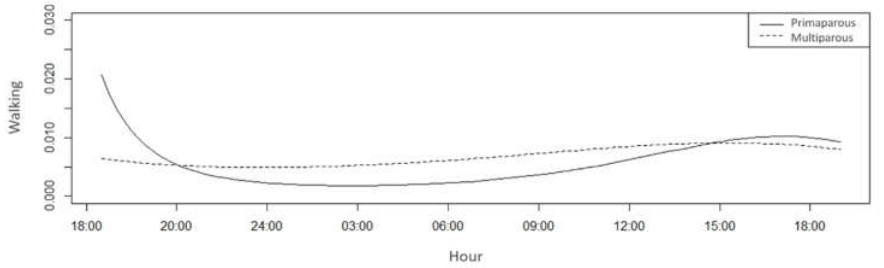
Figure 10. Walking probability of primiparous (solid line) and multiparous cows (dotted line) in a compost barn.